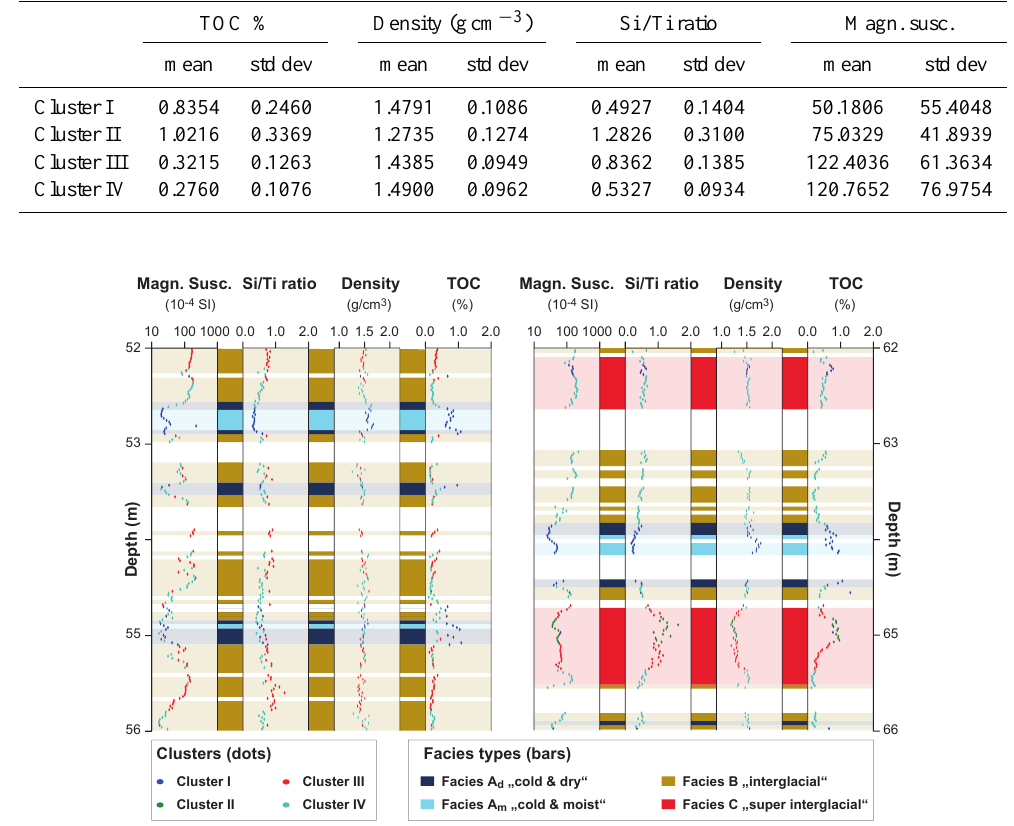
Fig. 7. Downcore distribution of facies types and clusters for 52 to 56 and 62 to 66mb.l.f. Facies description as in Fig. 3. Clusters are superimposed on magnetic susceptibility, Si/Ti ratio, density and TOC content and are color-coded as in Fig.